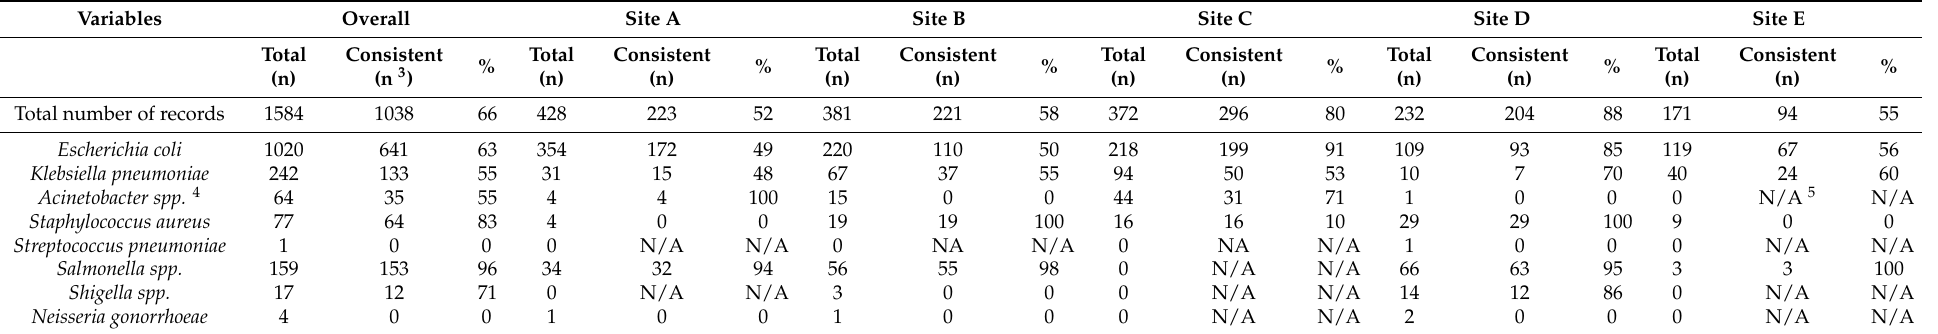
Table 2. Consistency in pathogen–antibacterial combination of AMR 1 surveillance data according to the GLASS 2 from five AMR surveillance sites in Province 3 of Nepal (January–June